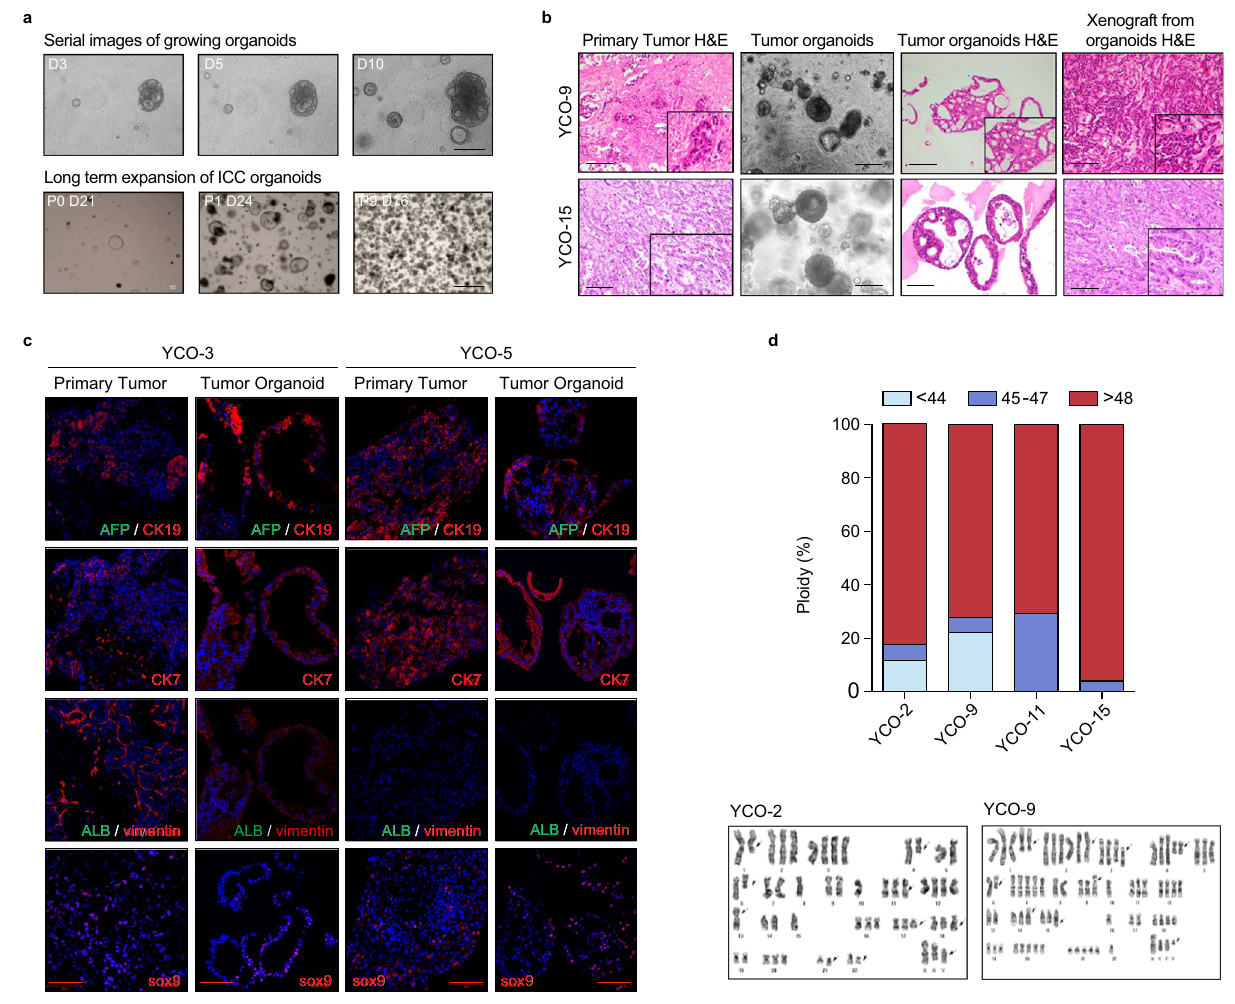
Fig. 1 | Establishment ofICC organoidsand demonstrationoftheir phenotypic similarity to corresponding primary tumors. a Time course of organoid growth ( n =16). Scale bar: 200 µ m. b Representative matching images of H&E-stained pri- marytumorsandorganoids,showingthemorphologicalandhistologicalsimilarity of ICC organoids to their matching primary cancer ( n =16). Scale bar: 100 µ m. c IF staining for the cholangiocyte ductal markers CK19 and Sox9 (red) and liver cell